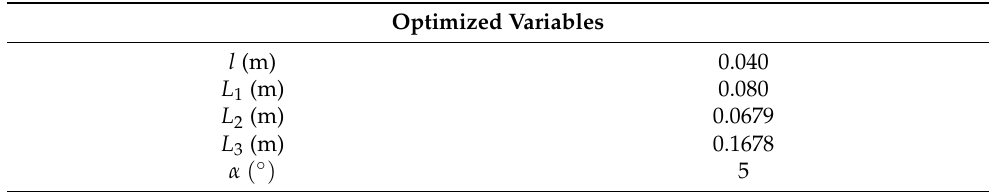
Table 1. Optimized design